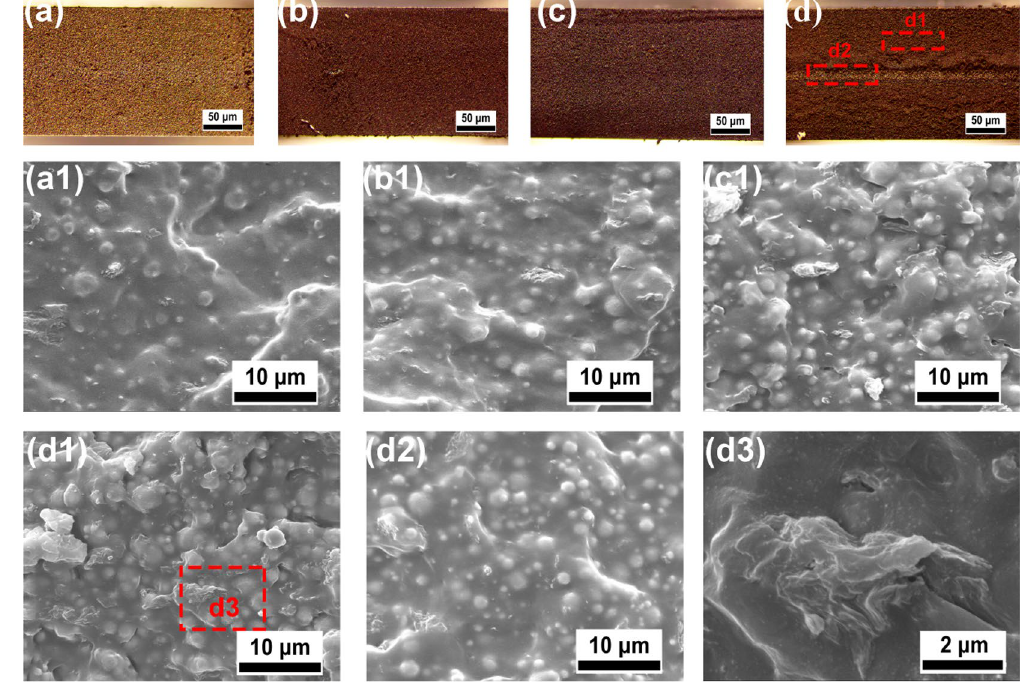
Figure 2. Optical microscopy and SEM images of the fractured surfaces of the composites after ageing at different temperatures: unaged ( a , a1 ), 200 °C × 24 h ( b , b1 ), 220 °C × 24 h ( c , c1 ), 240 °C × 24 h ( d , d1 , d2 ) and aggregated graphene ( d3 ).